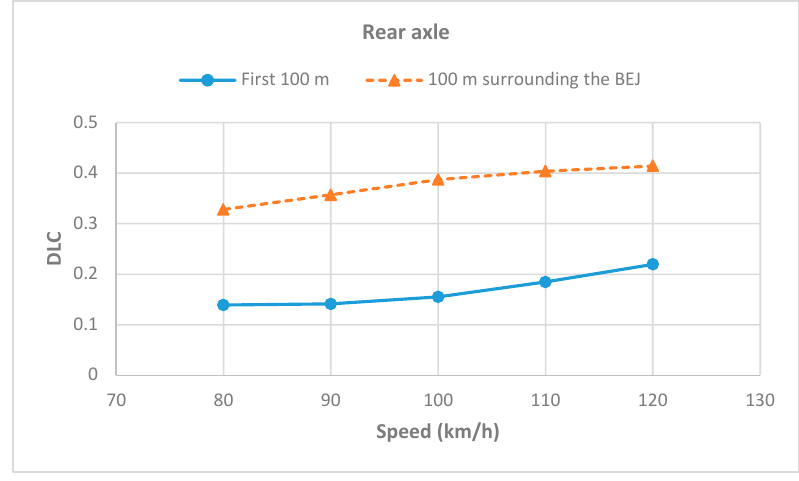
Figure 20. Dynamic load coefficient (DLC) values at different speeds before the bridge expansion joint and across it (Alignment 3).